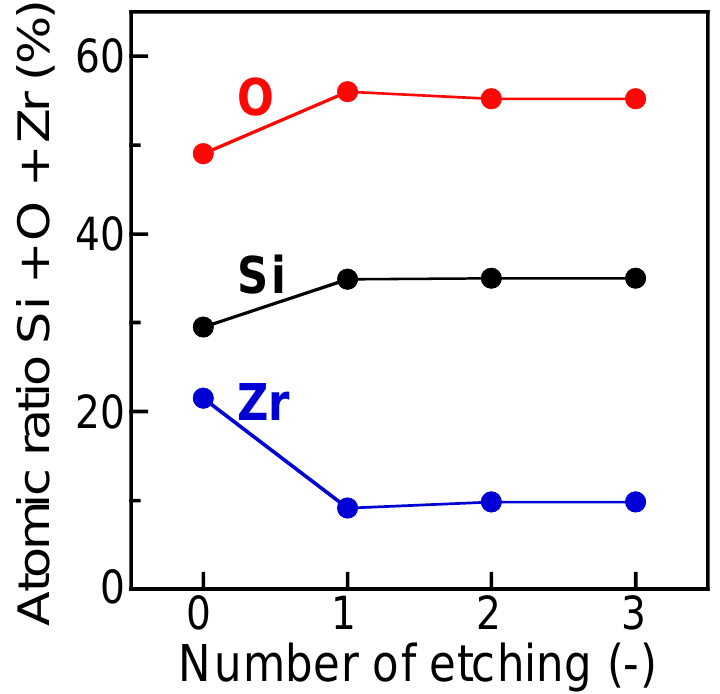
Figure 7. Atomic ratios in SiO 2 /ZrO 2 ‑coated substrate as a function of the number of Ar + etching steps. The as‑prepared sample was the same as that in Figure 5(b1).